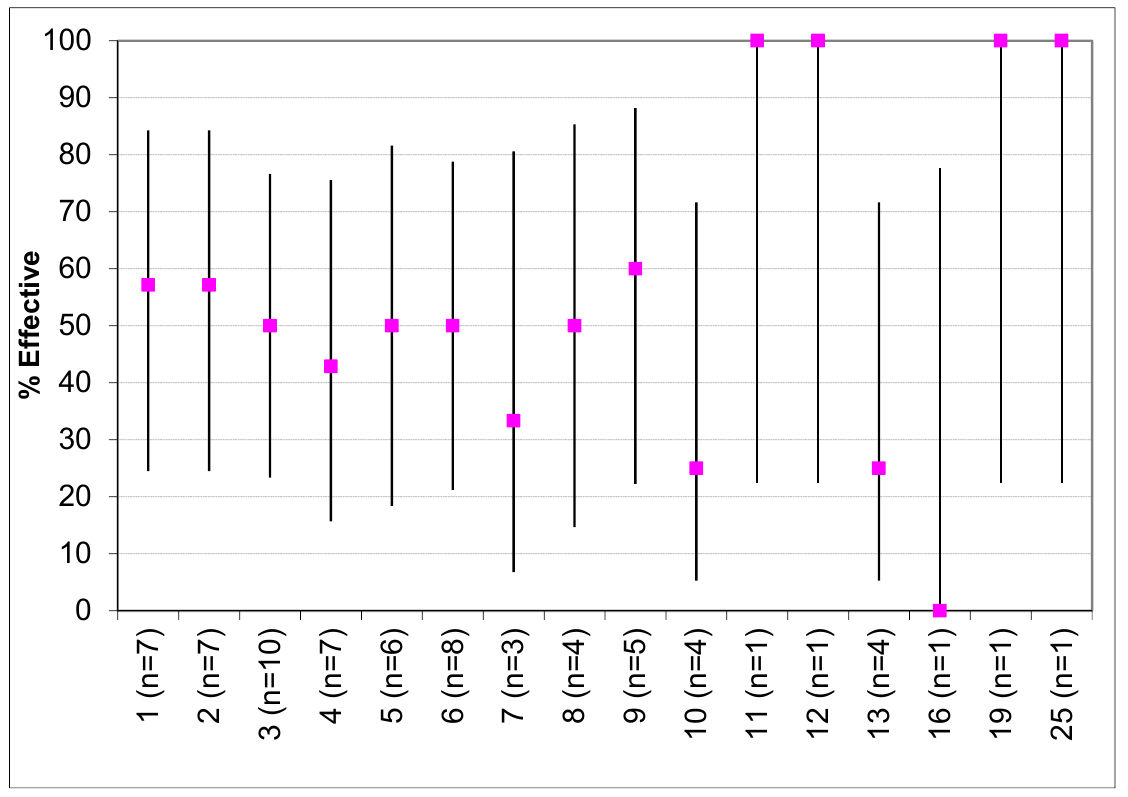
Figure 6. Percentage e ff ectiveness of interventions by number of behaviour change techniques.